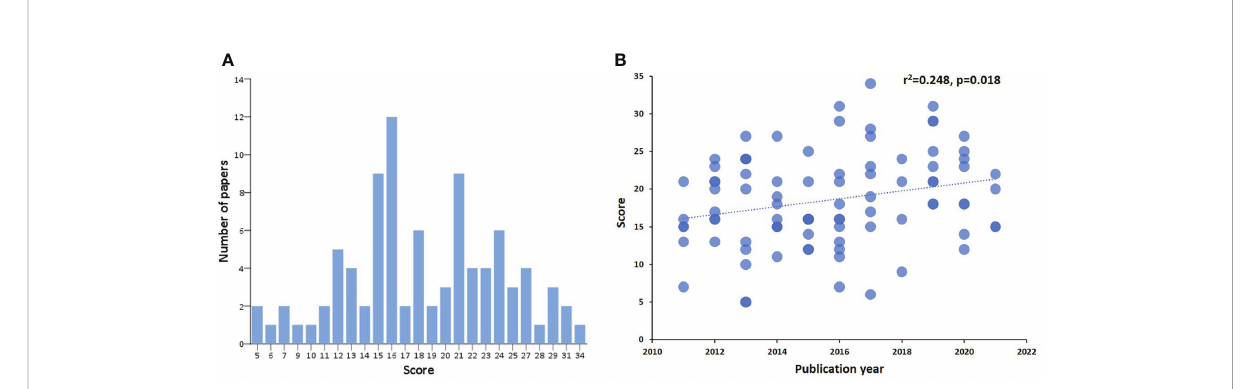
FIGURE 2 Score distribution of identi fi ed references and correlation with the year of publication. Score distribution of identi fi ed references (A) . The x-axis shows the score according to de fi ned NIH criteria on biomarker research, and the y-axis represents the number of publications per score value. Correlation of score to year of publication (B) . On the x axis the year of publication can be seen, on the y axis the assigned score of each manuscript published in the respective